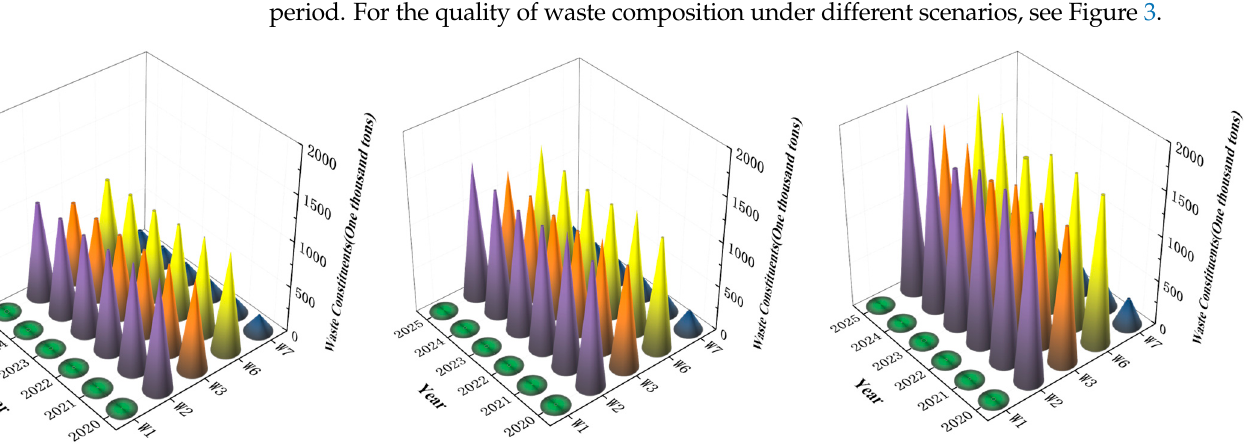
Figure 3. Volume of waste constituents under different scenarios.